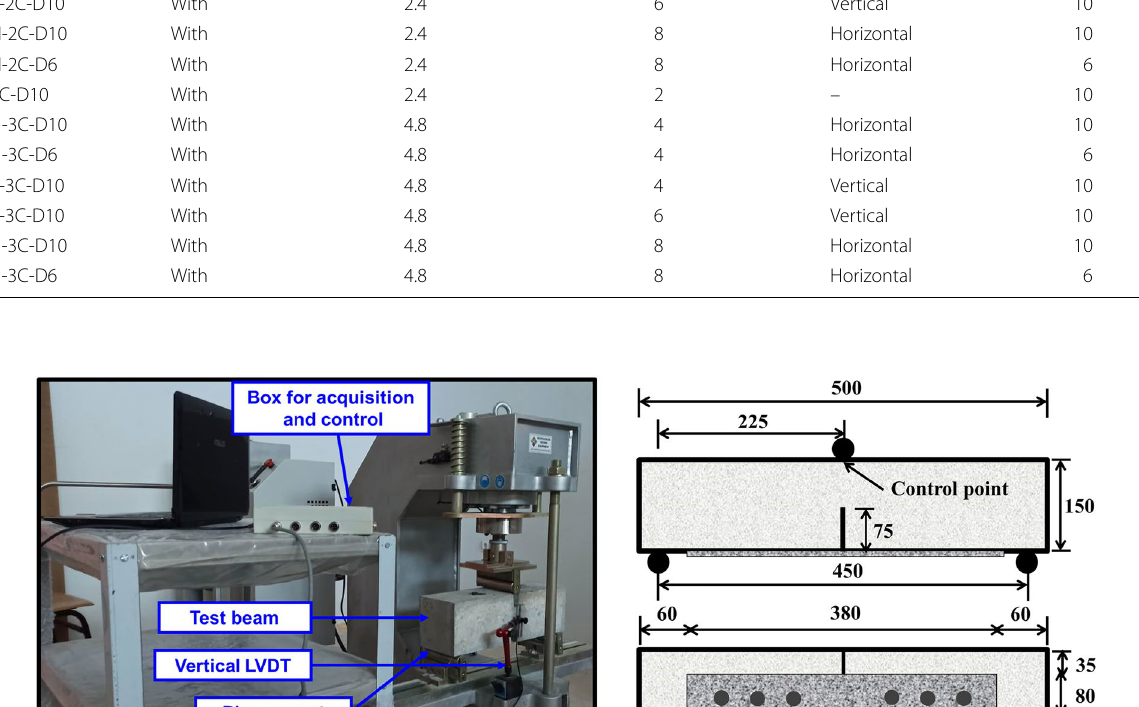
Figs. 7 and 8 display the failure modes for beams strengthened with bolts. The bolts’ numbers, posi- tions, and diameters have been investigated in this test. As displayed in Figs. 7b and 8a, the strength- ened beams 2B-1C-D10, 4B-H-1C-D10, 4B-V-1C-D10, 6B-V-1C-D10, 4B-H-1C-D6, flexural cracks are ini- tially formed in the maximum moment region and